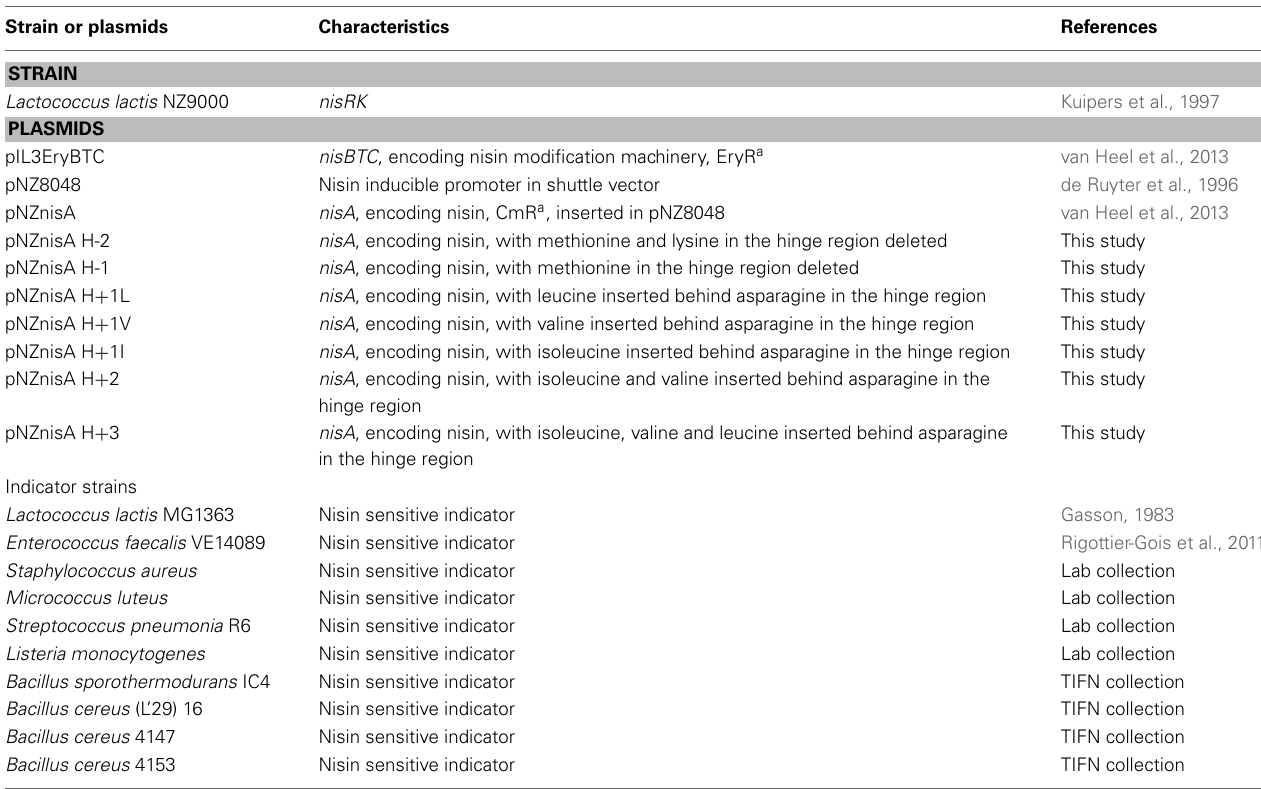
Table 1 | Strains and plasmids used in this study.